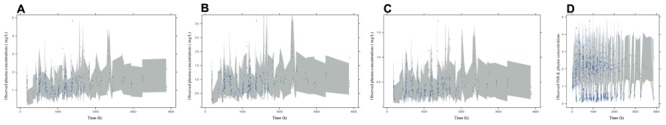
The VPC plots of PK models for warfarin (A), R-warfarin (B), and S-warfarin (C) and PK-PD model for S-warfarin (D). The Shadows were the 95th PIs.